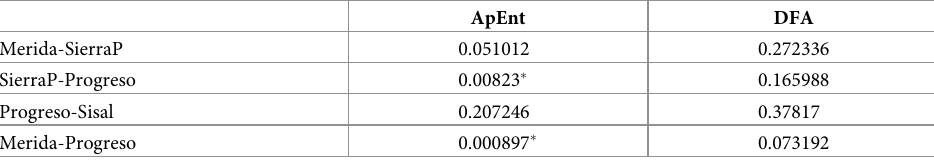
Table 2. P-values of the t-tests performed for neighboring cities.